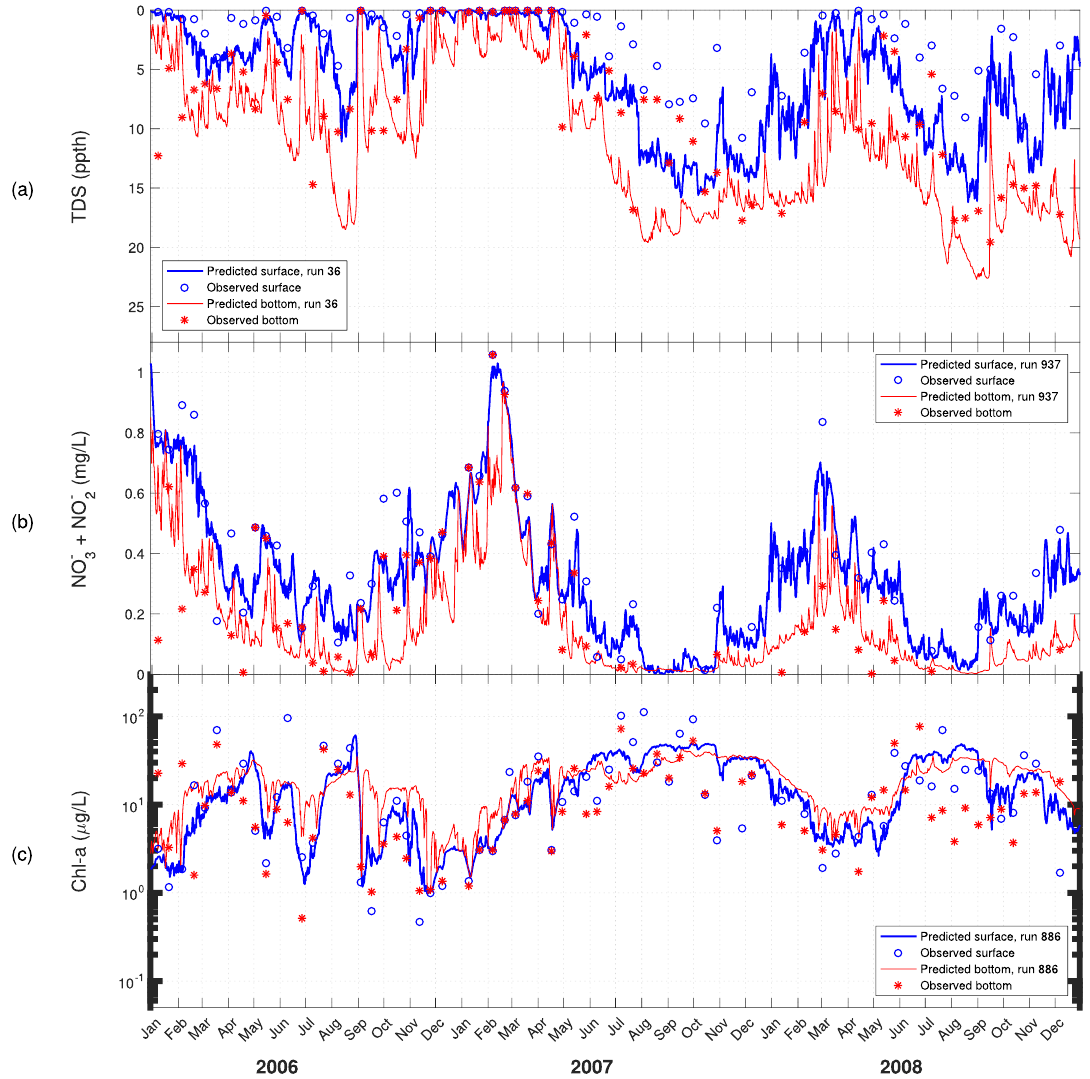
Figure 10. Time series for predicted versus observed values of: ( a ) salinity; ( b ) nitrate + nitrite; and ( c ) chlorophyll-a at ModMon 30 for 2006–2008.